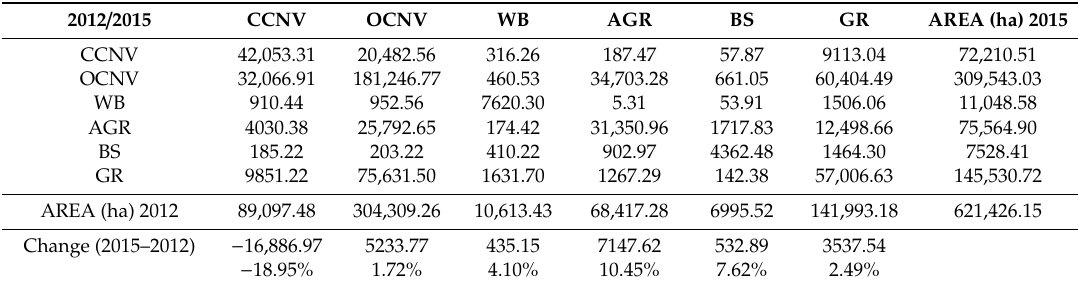
Table 8. Land cover change matrix relative to the period 2012–2015.